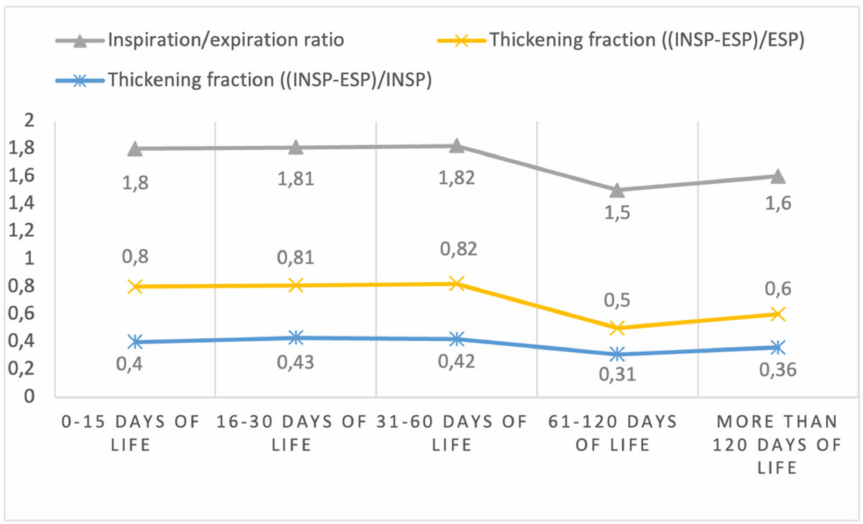
Figure 2. Diaphragm thickness during inspiration and expiration at different time points (mean val- ues).